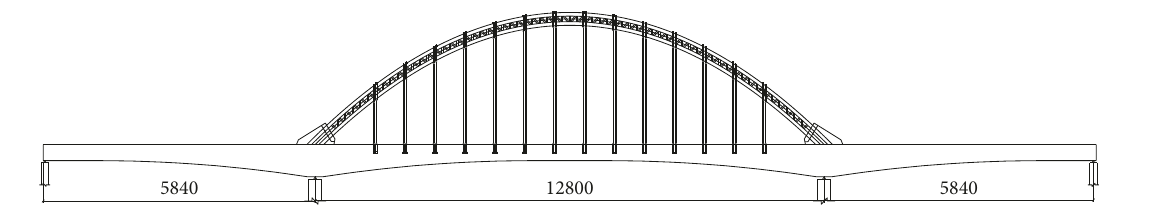
Figure 5: Elevation of the bridge (unit: cm).